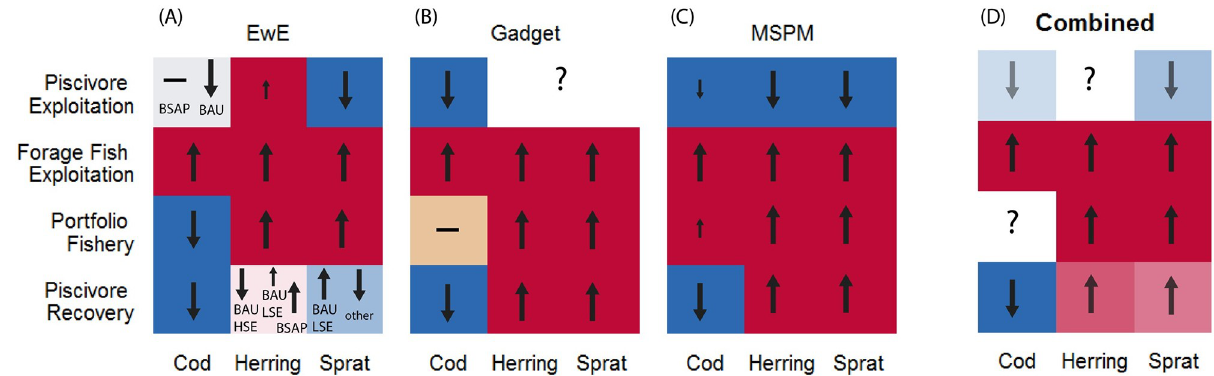
Fig 5. Required increases (upward arrows, red tiles), decreases (downward arrows, blue tiles) by 10–20% (small arrows) or more (large arrows), or no change (hyphen, beige tiles) compared to Status Quo Fs to achieve objectives of each management scenario according to each model (A-C) and combined (D). Lighter tiles indicate uncertainty in advice. In (A) they indicate cases when the advice provided by EwE on F was sensitive to the environmental scenario. In (D) light tiles indicate model differences in the combined information from (A)-(C). White tiles (question mark) represent cases when the model does not inform about Fs maximizing scenario objectives (B) or completely contradictory information from the model ensemble (D). BSAP indicates ‘Baltic Sea Action Plan’, BAU ‘Business-As-Usual’, HSE ‘high seal growth’ and LSE ‘low seal growth’ scenarios. ‘Other’ in (A) refers to all other scenario combinations except of BAU-LSE.